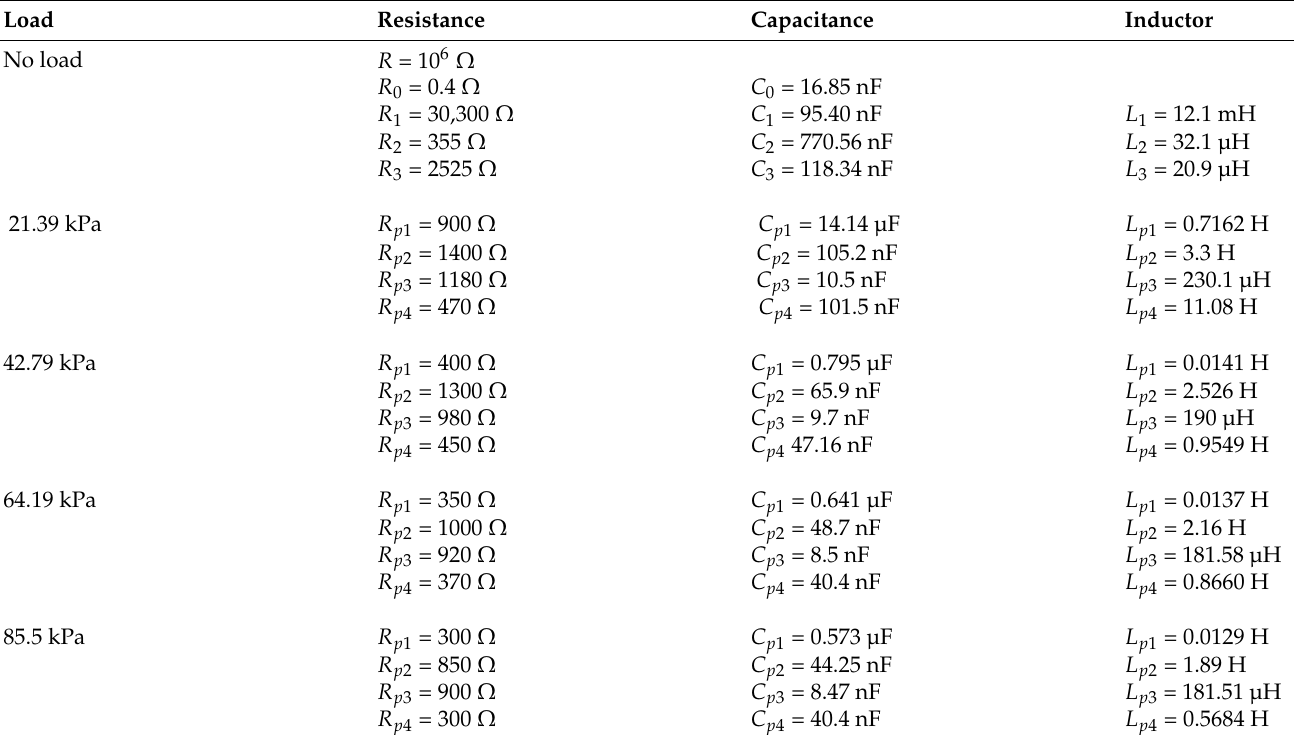
Table 4. Model parameters for PZT-27 with mechanical load.